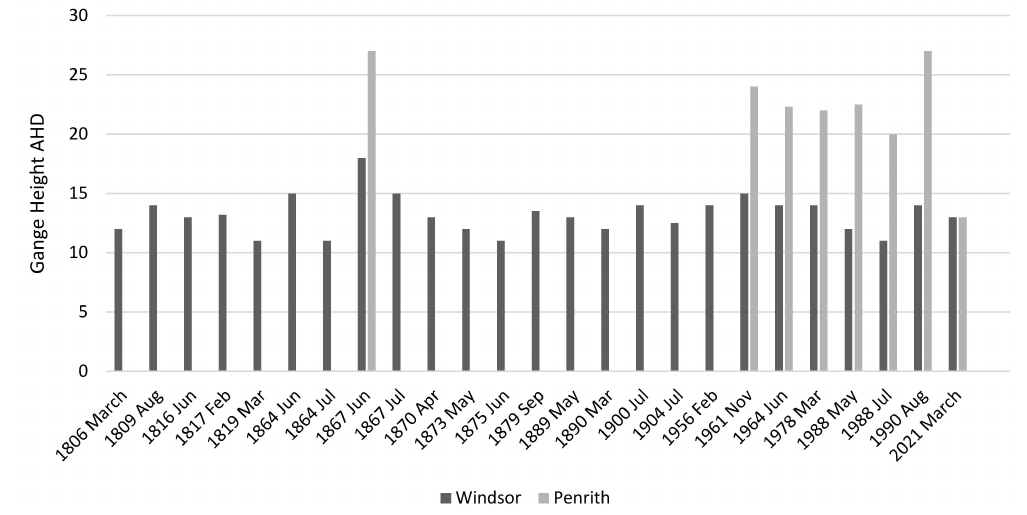
Figure 5. Major flood events of Hawkesbury-Nepean valley displaying a level of 12.2 m or above at Windsor